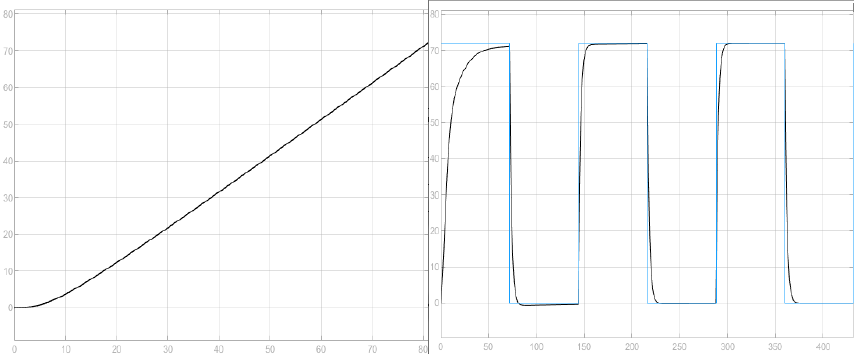
Figure 33. Response of the finished process to a ramp input and a pulse generator, n = 6.